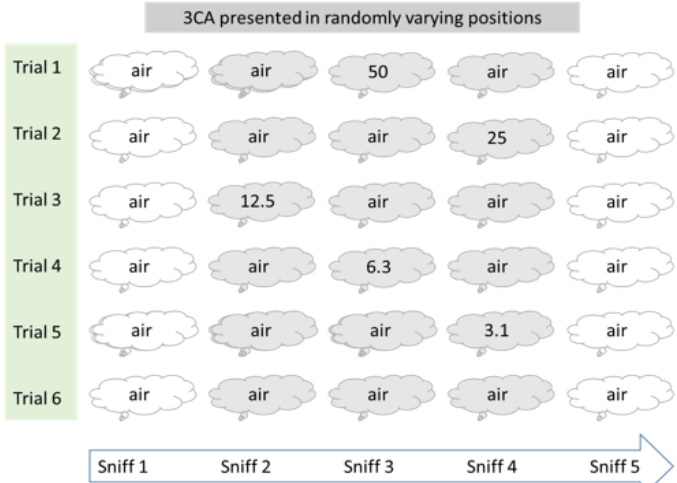
Figure 1. Oder detection setup. The presentation of 2,4,6-trichloroanisole (3CA) at different concentrations (ng/m 3 ) was randomly assigned to the 2nd, 3rd, or 4th sniff.